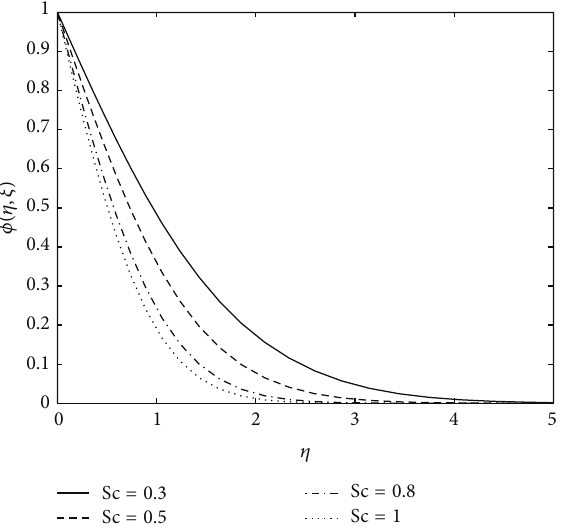
Figure4:EffectoftheSchmidtnumberontheconcentrationprofile.